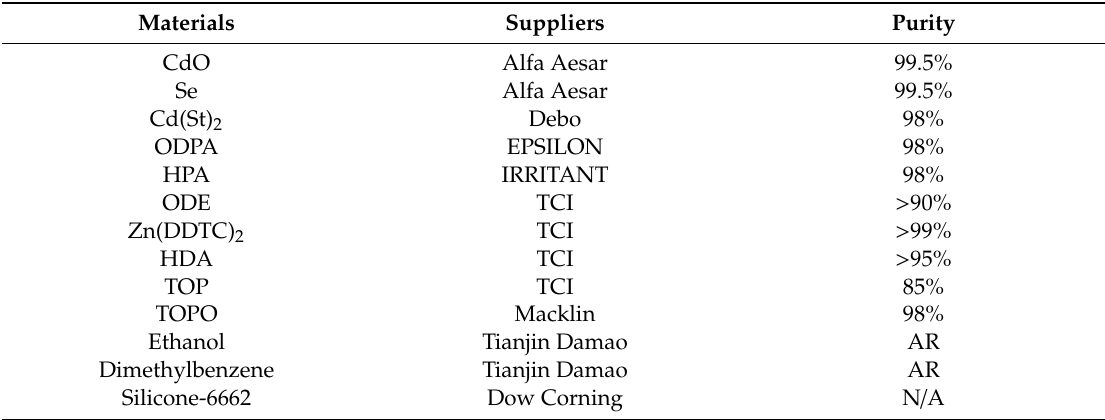
Table 1. Material manufacturer and